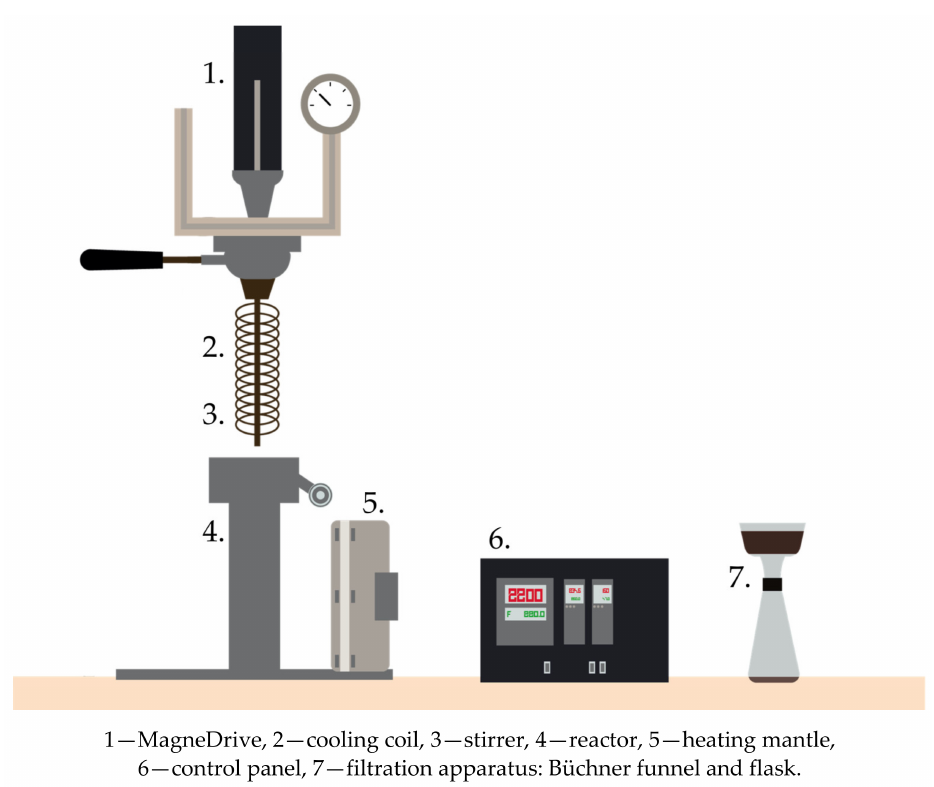
Figure 3. Experimental setup used for hydrothermal carbonization and filtration